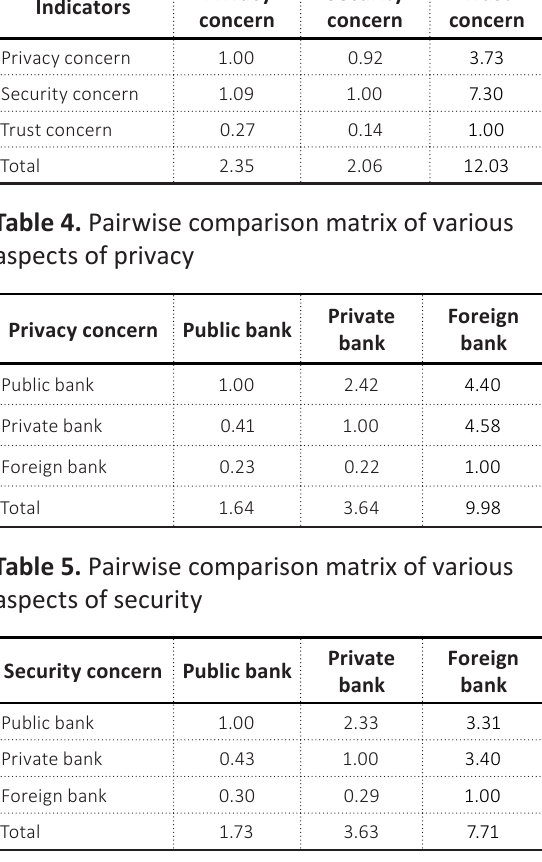
Table 6. Pairwise comparison matrix of various aspects of